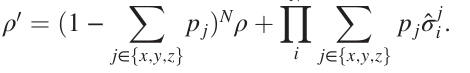
˜ Z R and RSS ¼ T